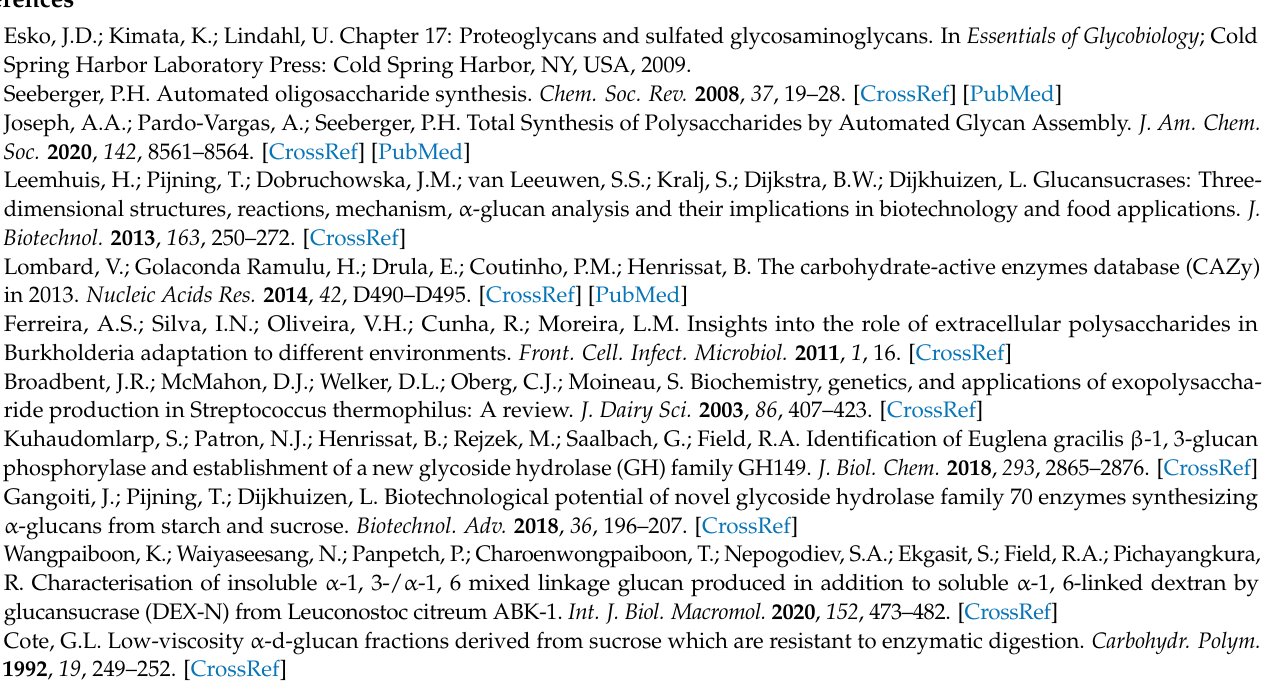
from WT and W675A reaction via sucrose reaction, Figure S9: Purification of maltose reaction from WT reaction, Figure S10: Purification of maltose reaction from WT reaction, Figure S11: HPAEC-PAD profiles of maltose reaction produced from WT and W675A, Figure S12: Ramachandran plot of the homology model of Leuconostoc citreum ABK-1 alternansucrase, Figure S13: RMSD plots of alternan- sucrase with glc-D635 intermediate. The RMSD values of all atoms and backbone atoms are shown in black and grey, respectively, Figure S14: Superimposition of the crystal binding conformation (black) and the best docked conformation (cyan), Figure S15: RMSD plots of A) maltose-ALTwt and B) maltose-ALTW675A complexes. The RMSD values of all atoms, backbone atoms and ligand atoms are shown in black, grey and blue, respectively, Table S1: List of primers for site-directed mutagenesis at W675